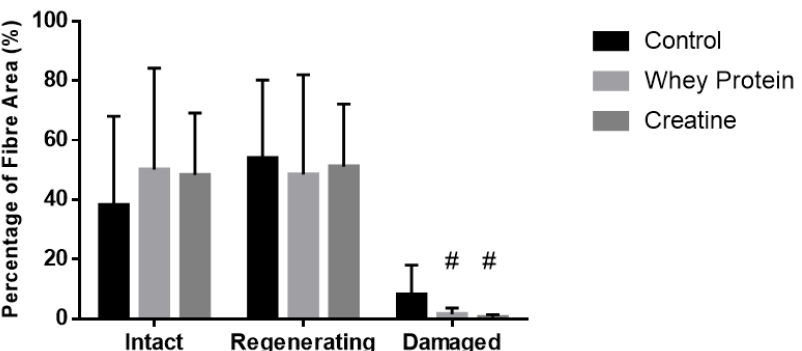
Figure 5. Muscle fiber recovery (expressed as a % of muscle CSA) of injured EDL muscles from rats treated with standard rat chow- (CON-), whey protein- (WP-), or creatine- (CR-) supplemented rat chow at day 14 post-injury. Values are mean ± SD expressed as either % of undamaged (intact) fibers, regenerating fibers, and damaged fibers. # ( p < 0.01) significantly different from the injured CON